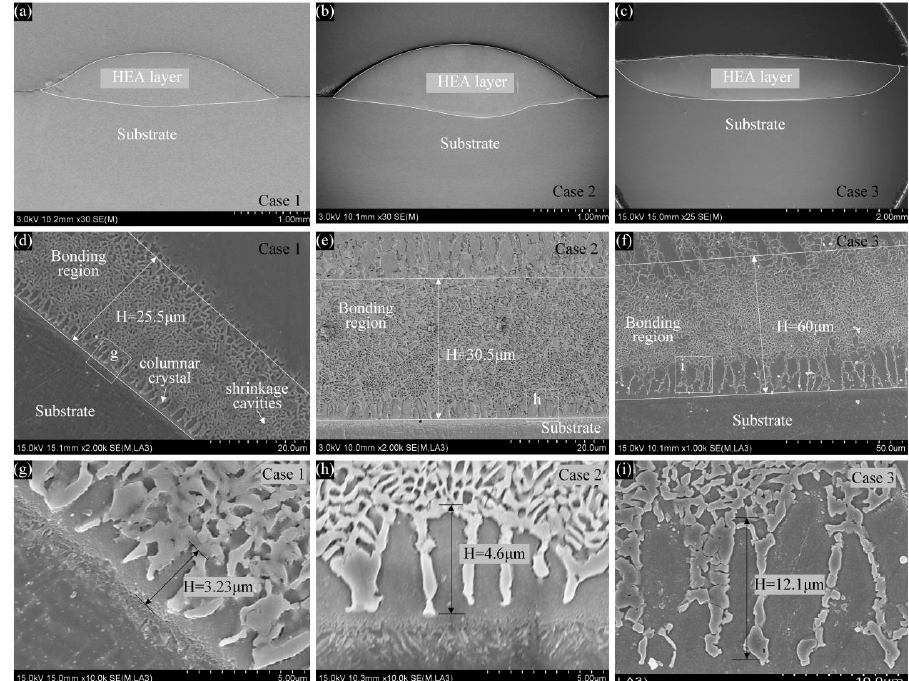
Figure 6. ( a ) SEM image of the transverse section of Case 1, ( b ) SEM image of the transverse section of Case 2, ( c ) SEM image of the transverse section of Case 3, ( d ) high-magnification SEM image of bonding region in Case 1, ( e ) high-magnification SEM image of bonding region in Case 2, ( f ) high-magnification SEM image of bonding region in Case 3, ( g ) high-magnification SEM image of the localized region marked in ( d ), ( h ) high-magnification SEM image of the localized region marked in ( e ), ( i ) high-magnification SEM image of the localized region marked in ( f ).